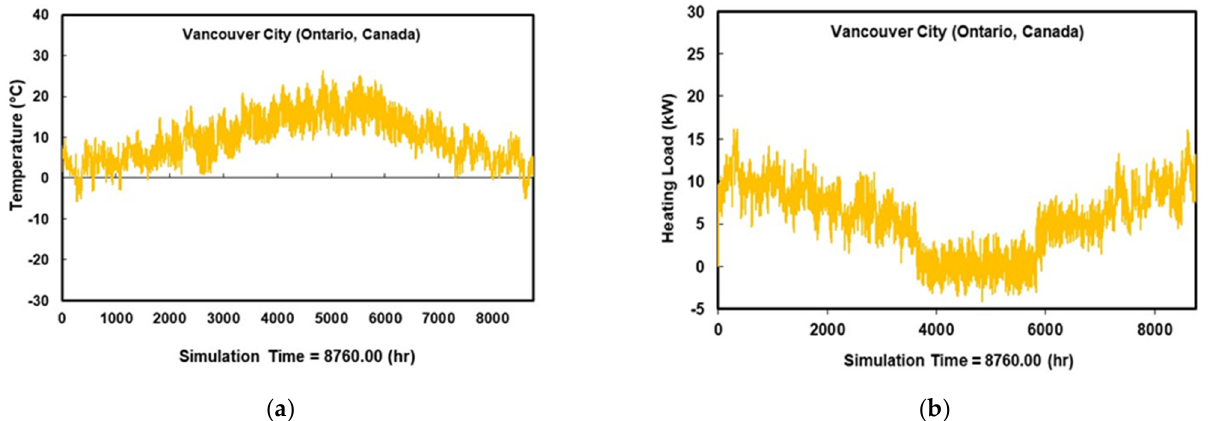
Figure 6. ( a ) Ambient air temperature; ( b ) house heating load during a one-year period for Vancouver.